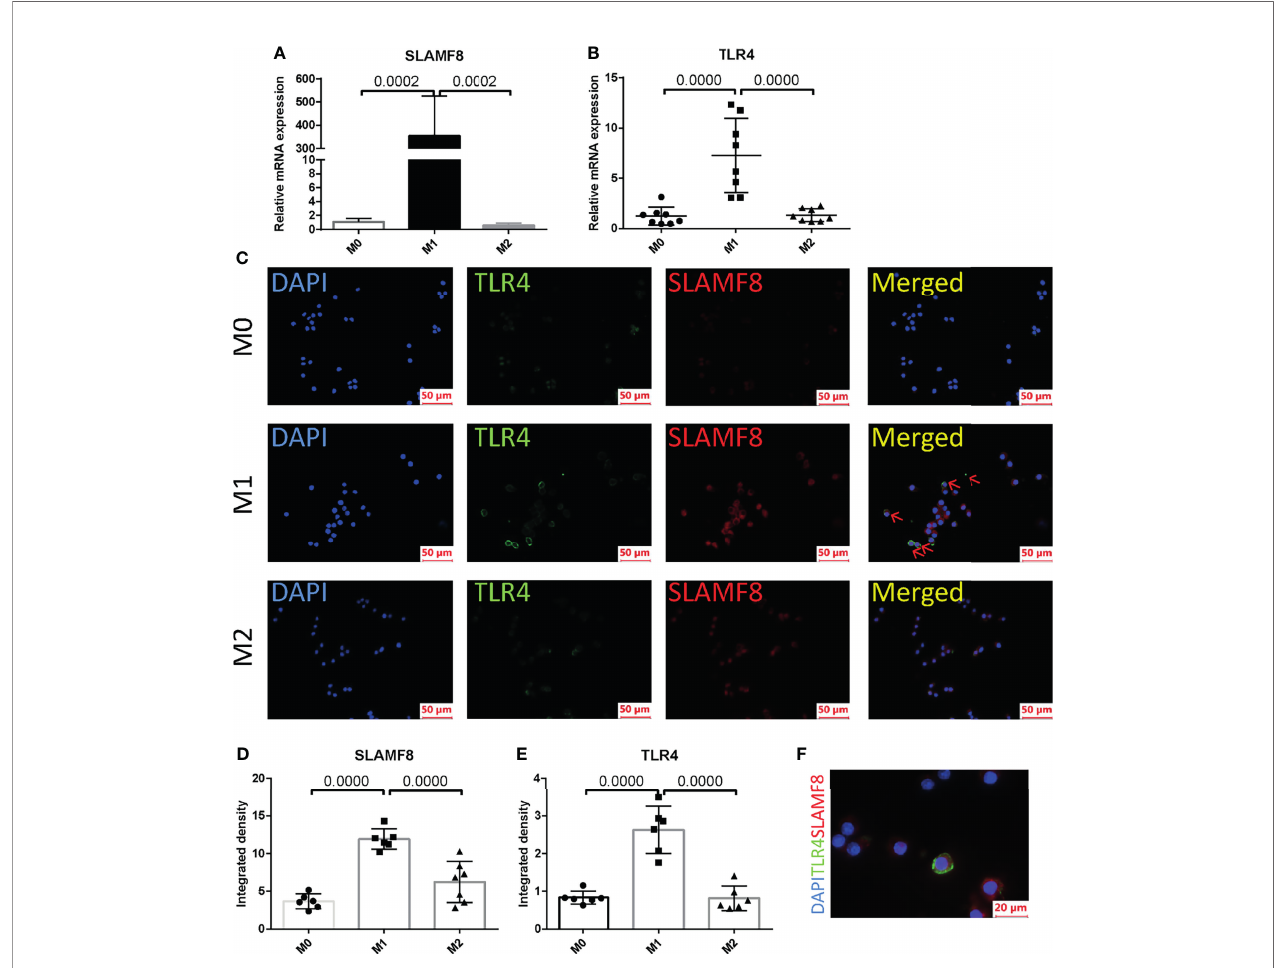
FIGURE 9 | SLAMF8 and TLR4 are co-expressed in M1-type macrophages. Relative mRNA expression of SLAMF8 (A) and TLR4 (B) were measured in M0, M1, and M2. (C – E) Representative and quanti fi cation of immuno fl uorescence staining of TLR4 (green) and SLAMF8 (red) in M0, M1, and M2. Red arrow indicates cells co-expressing TLR4 and SLAMF8. Scale bar=50 m m; six random fi elds were taken from each coverslip (mean±SD, n=6). (F) Representative of immuno fl uorescence staining of TLR4 (green) and SLAMF8 (red) in M1. Scale bar=20 m m. M0, murine RAW 264.7; M1, RAW 264.7 treated with 10 ng/ml LPS plus 20 ng/ml IFN g for 24 h; M2, RAW 264.7 treated with 10 ng/ml IL-4 for 24